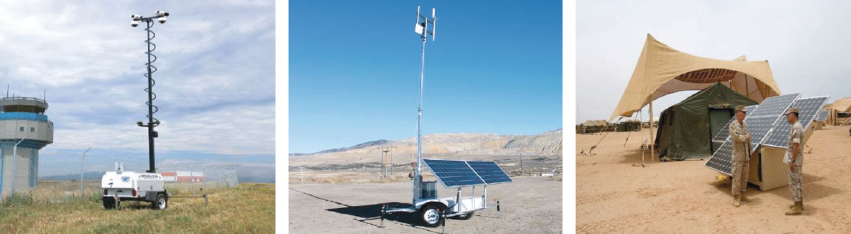
Figure 2: Solar remote power station [5].